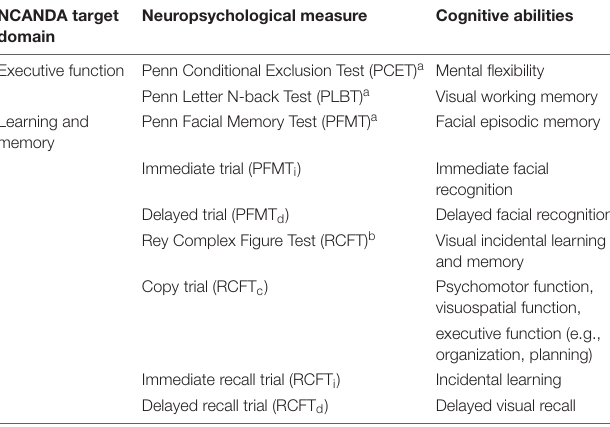
TABLE 1 | Neuropsychological measures and associated cognitive domains. NCANDA target